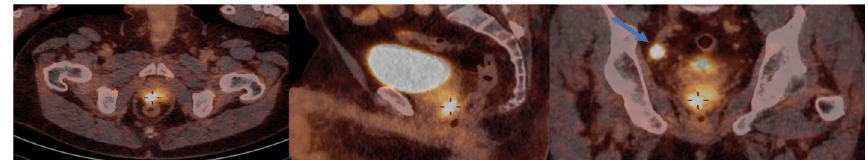
Fig. 5 PSMA-positive prostate lesion on the pre-surgery PSMA PET/CT of the patient 02; the blue arrow represents an iliac lymph